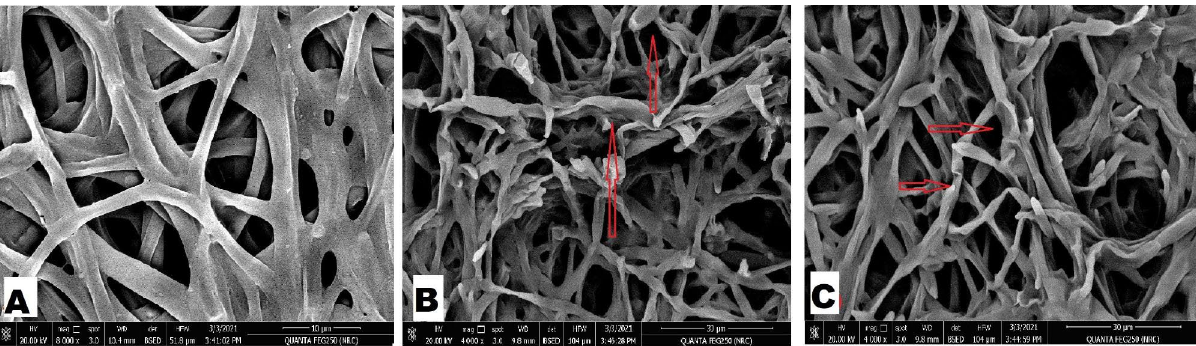
Fig. 2 Photographs of roots of Phaseolus vulgaris . Roots of infected plants (A) , Roots of control plants (B) , Roots of infected plants reated with NPs accord- ing to the protective plan (C) , and Roots of infected plants reated with NPs according to the protective plan